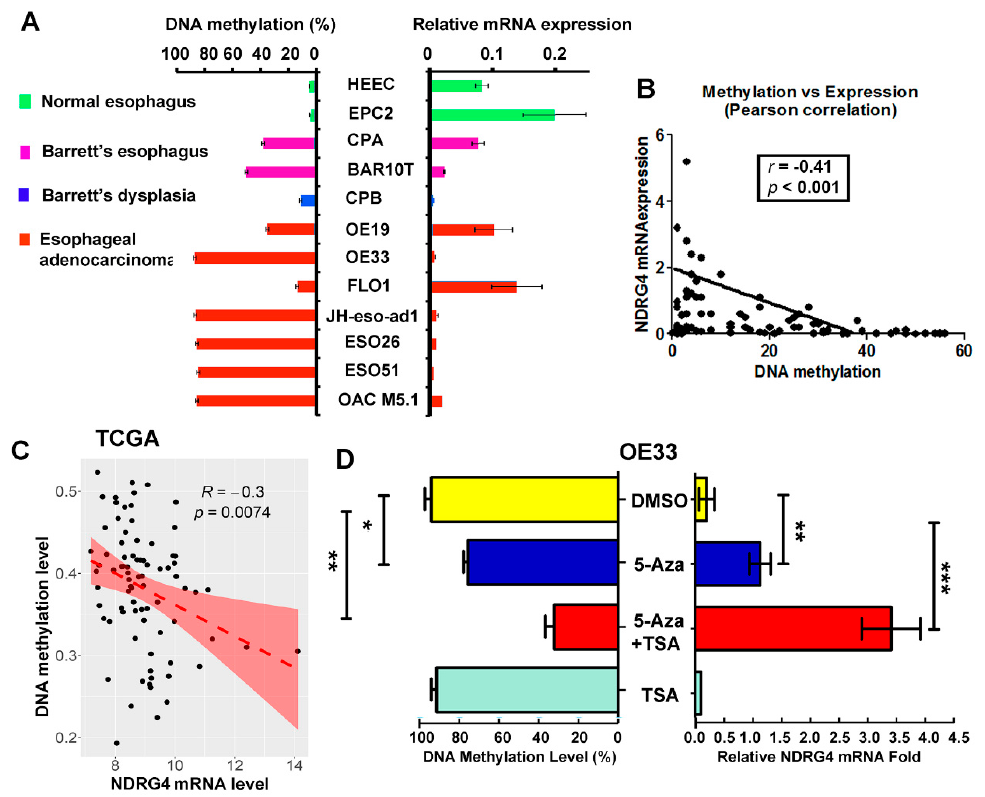
Figure 4. NDRG4 promoter DNA methylation levels inversely correlated with NDRG4 gene expression. ( A ) Side by side comparison of NDRG4 promoter DNA methylation levels detected by pyrosequencing (left) with NDRG4 gene expression levels by qPCR (right) in 12 esophageal cell lines. ( B ) Pearson correlation analysis of NDRG4 promoter DNA methylation levels with NDRG4 gene expression levels in all samples ( n = 81) demonstrated an inverse correlation. ( C ) Correlation analysis of DNA methylation and gene expression data of NDRG4 from TCGA database ( n = 81) confirmed an inverse relationship between NDRG4 DNA methylation and gene expression. ( D ) OE33 cells were treated with 5 µM 5-Aza alone or in combination with 100 nM TSA. qPCR was used to evaluate relative mRNA fold change of NDRG4 (right) and Pyrosequencing was used to quantitate NDRG4 methylation level change (left). * p < 0.05; ** p < 0.01; *** p < 0.001.